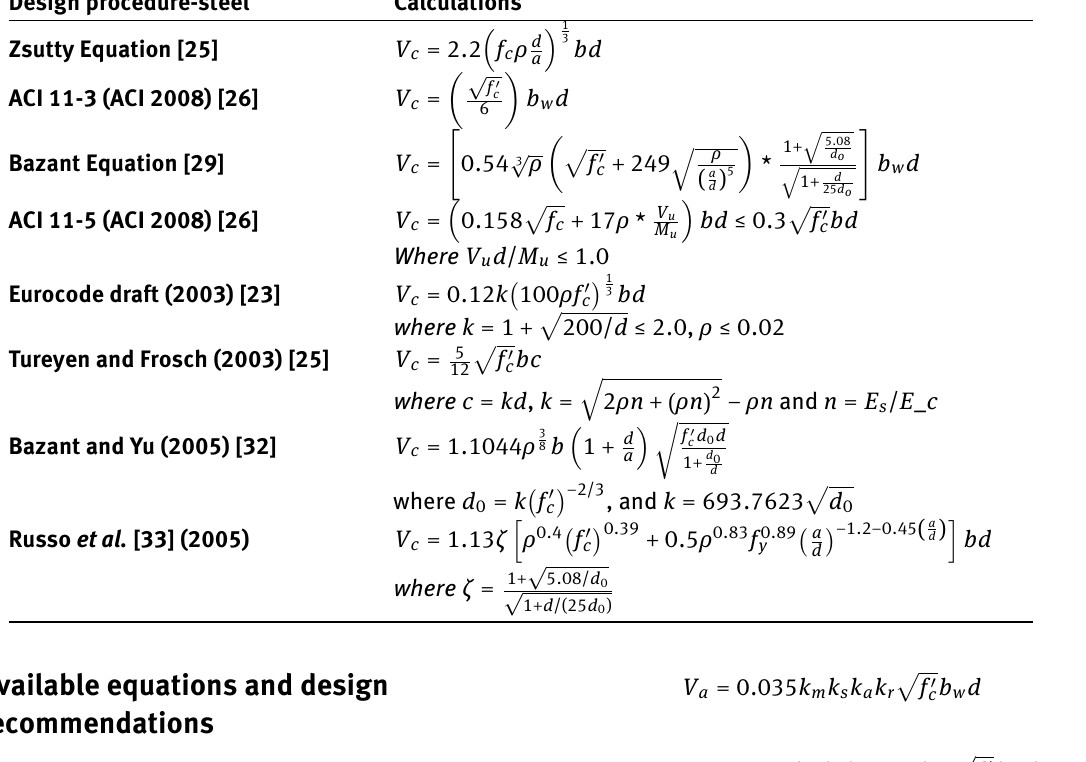
Table 7: Shear capacity of concrete beams reinforced with steel bars without shear reinforcement Design